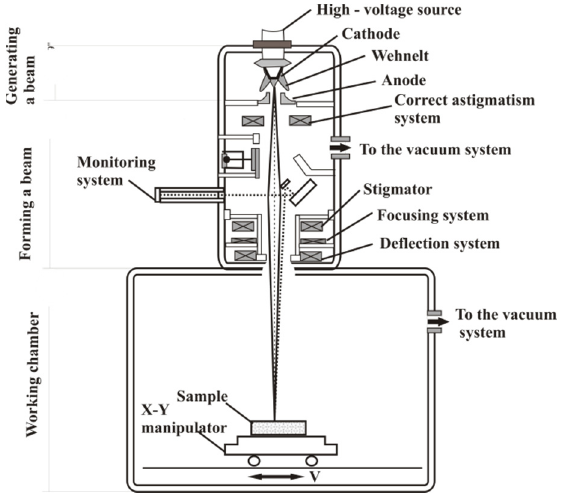
Figure 1. Scheme of electron-beam equipment for surface modification.